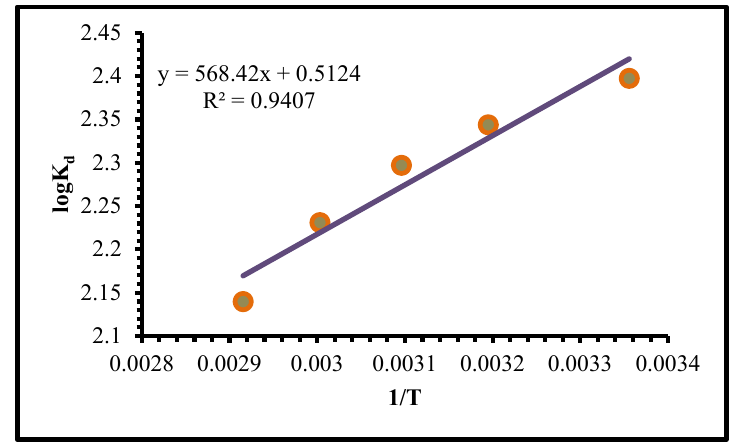
Figure 12. Plot of log K d vs. 1/T of Mo(VI) adsorption on TIHP adsorbant.